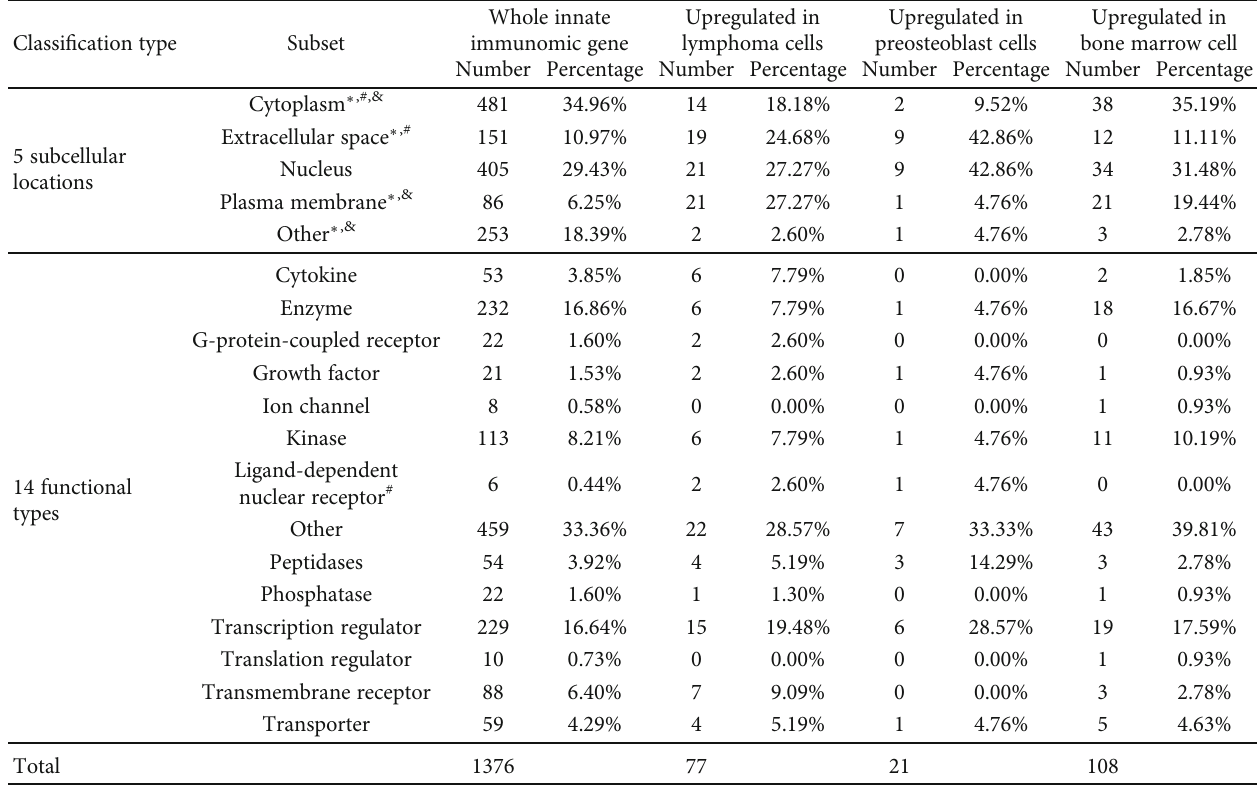
(a) The Ingenuity Pathway Analyses (IPA) showed that three out of fi ve subcellular localization groups (cytoplasm, extracellular space, and others) of LIUS-upregulated innatomic genes in lymphoma cells, preosteoblast cells, and bone marrow cells are signi fi cantly changed. However, none of the 14 functional groups of LIUS-upregulated innatomic genes in these three cell types were changed